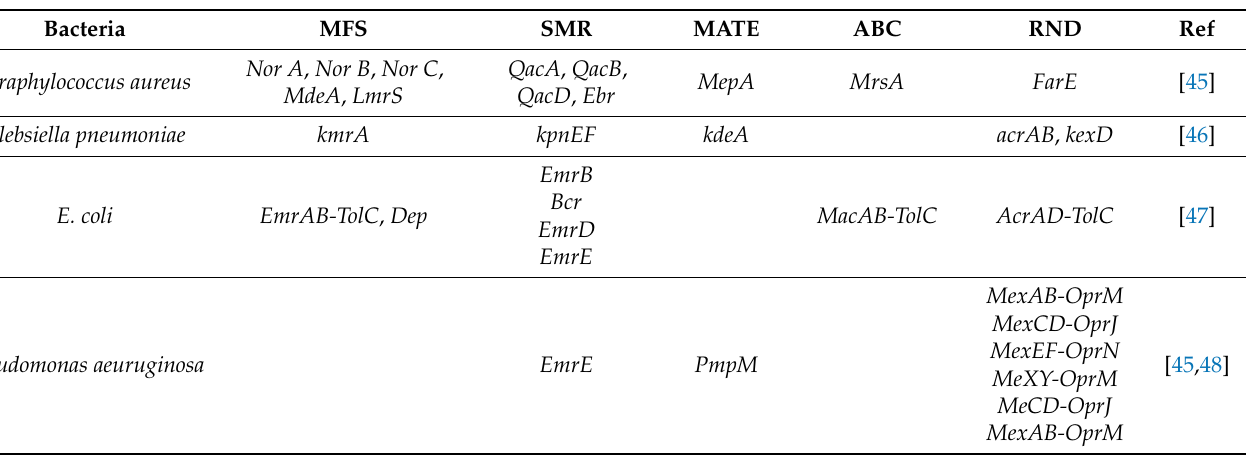
Table 2. Examples of efflux pump systems in